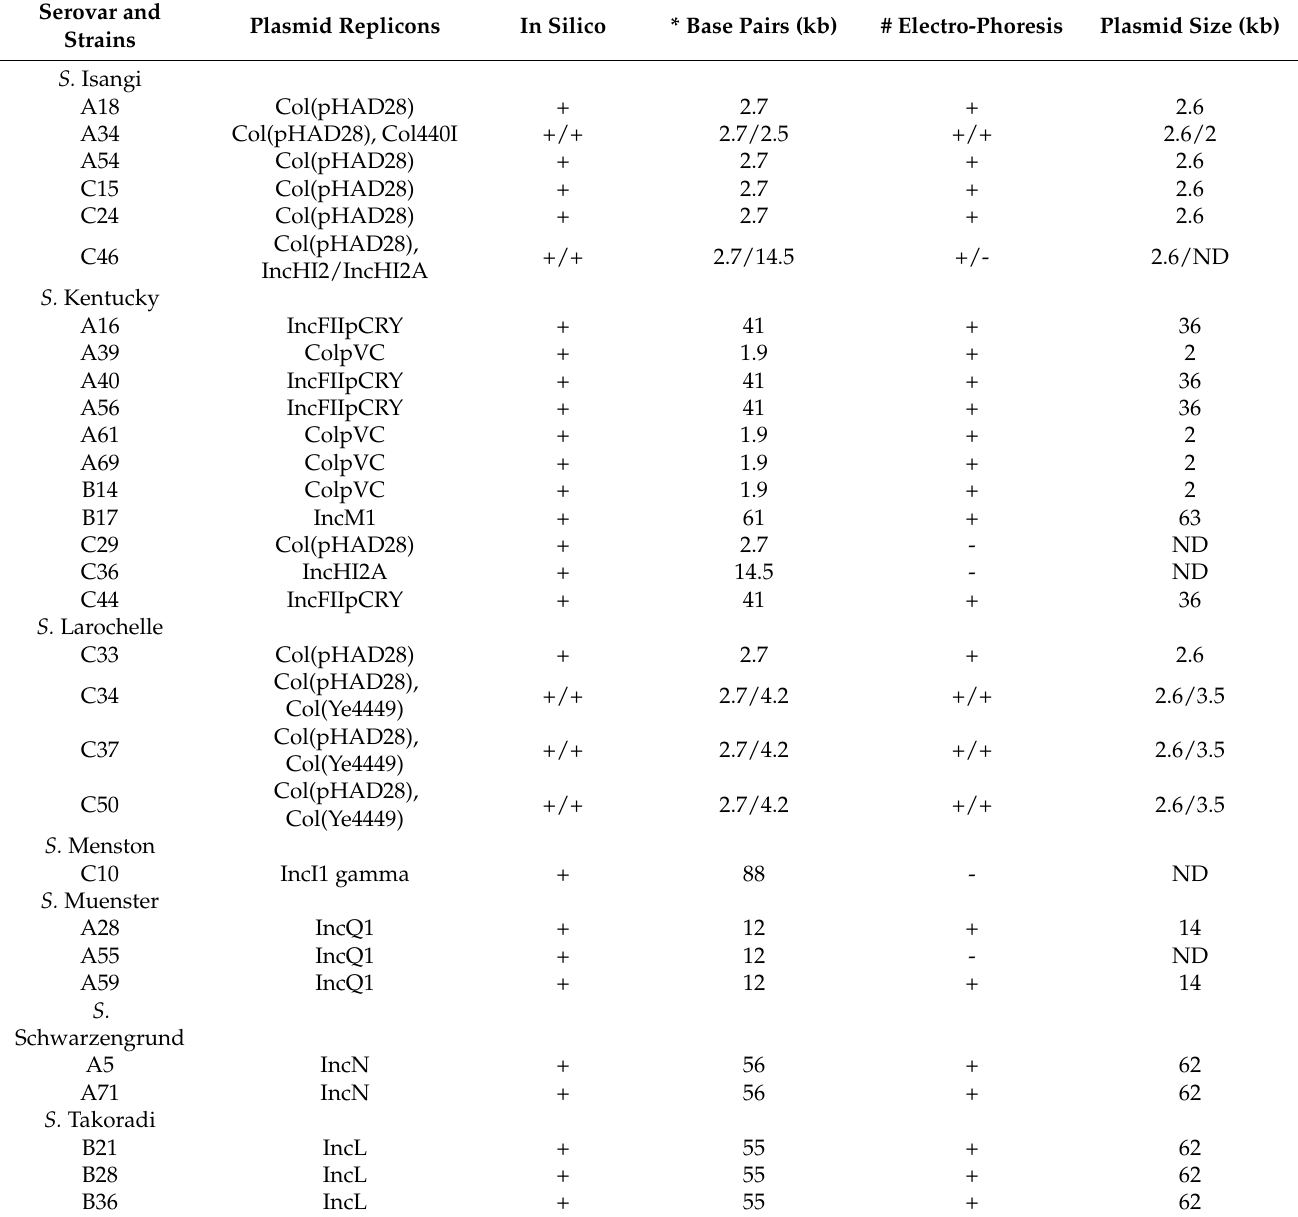
Table 3. Comparison between in silico plasmid prediction and detection of plasmids by gel electrophoresis. Serovar